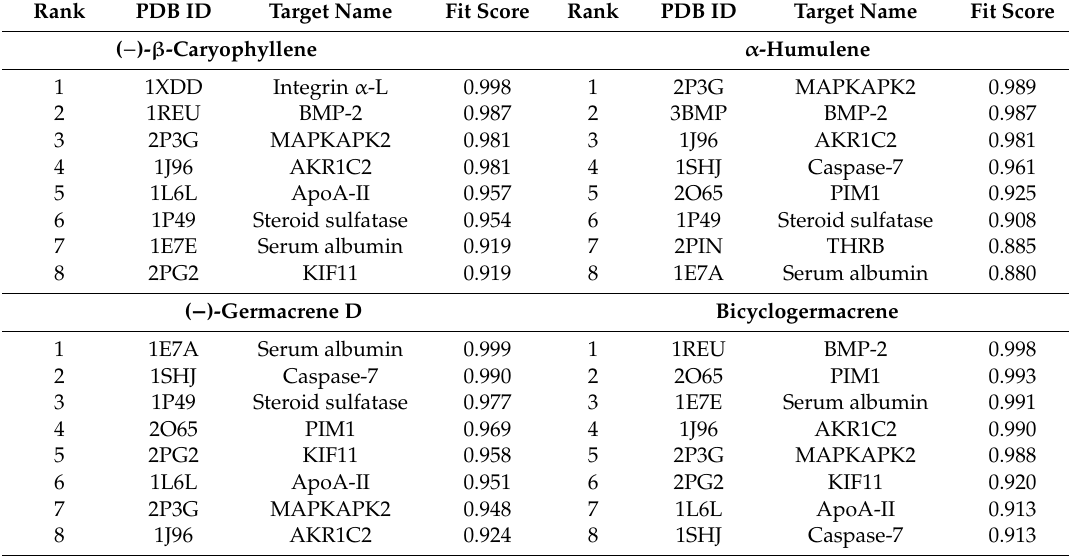
Identification of potential protein targets of ( − )- β -caryophyllene, ( − )-germacrene D, α -humulene, and bicyclogermacrene.